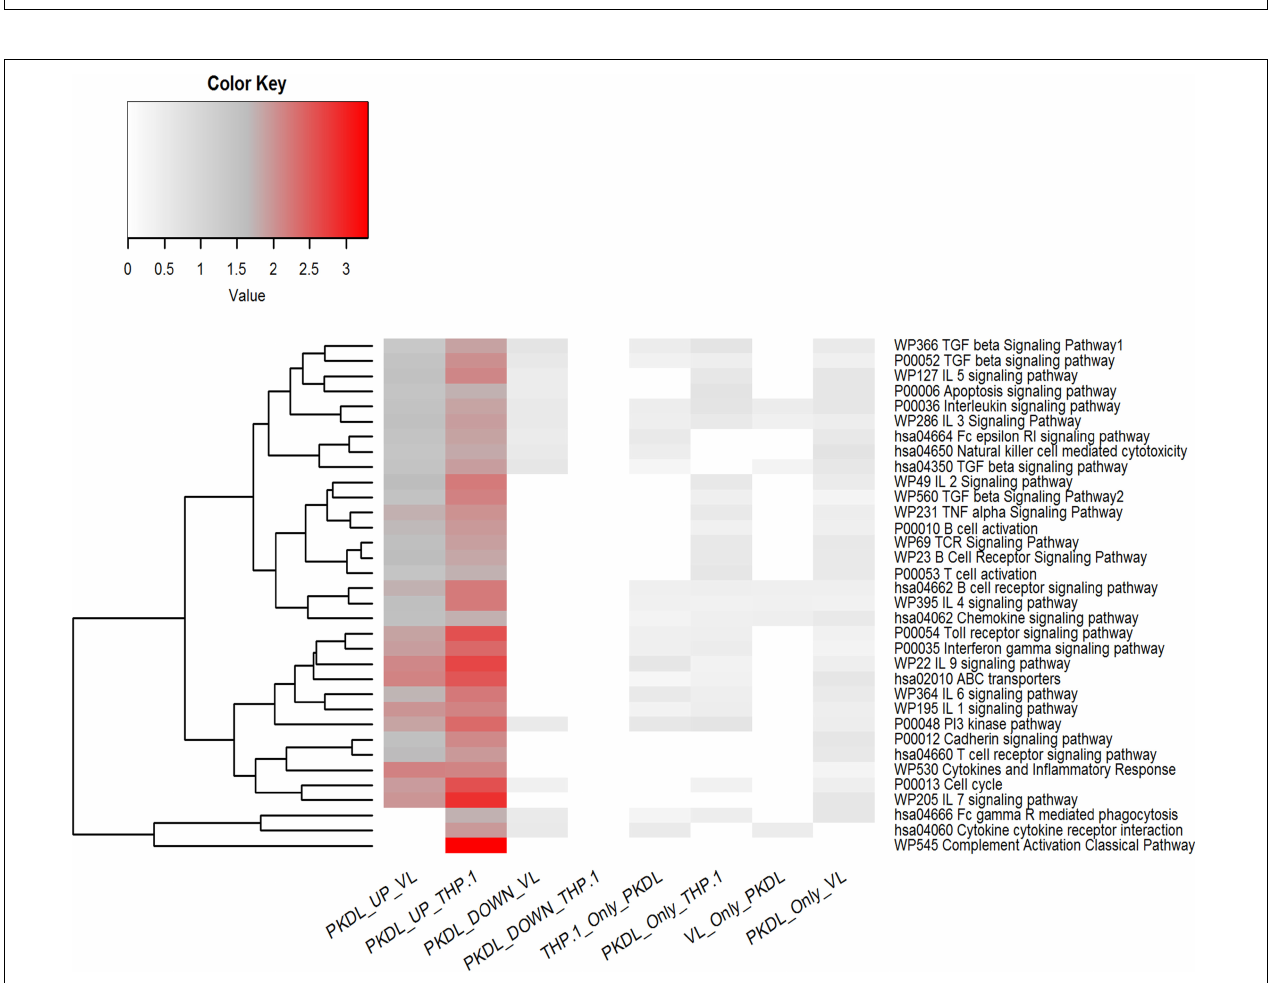
FIGURE 6 | Venn diagram shows the post-kala-azar dermal leishmaniasis (PKDL) responsive downregulated microRNA (miRNA). (A) Overlaps of known downregulated miRNAs of G PKDL with respect to G THP (PKDL–THP-1) and G VL (PKDL–visceral leishmaniasis (VL)]. (B) Overlaps of the novel downregulated miRNAs of G PKDL with respect to G THP (PKDL–THP-1) and G VL (PKDL–VL).